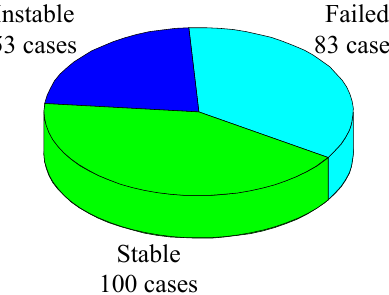
Figure 1. Distribution of pillar stability levels.